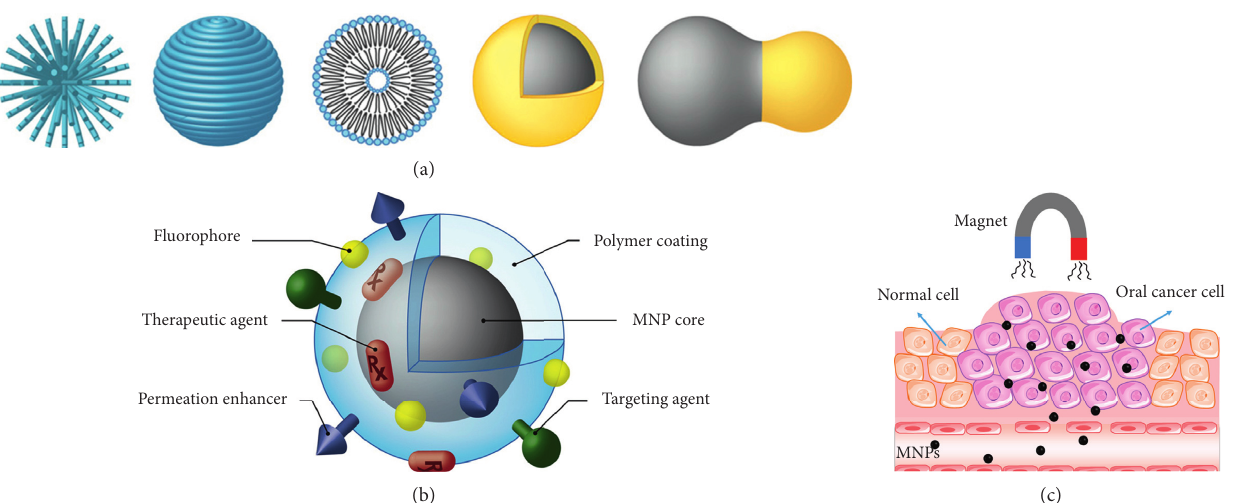
Figure 5: (a) MNP structures and coating schemes [23]. (b) MNP possessing various ligands to enable multifunctionality [23]. (c) The therapeutic effect of magnetic NPs under the control of an external magnetic